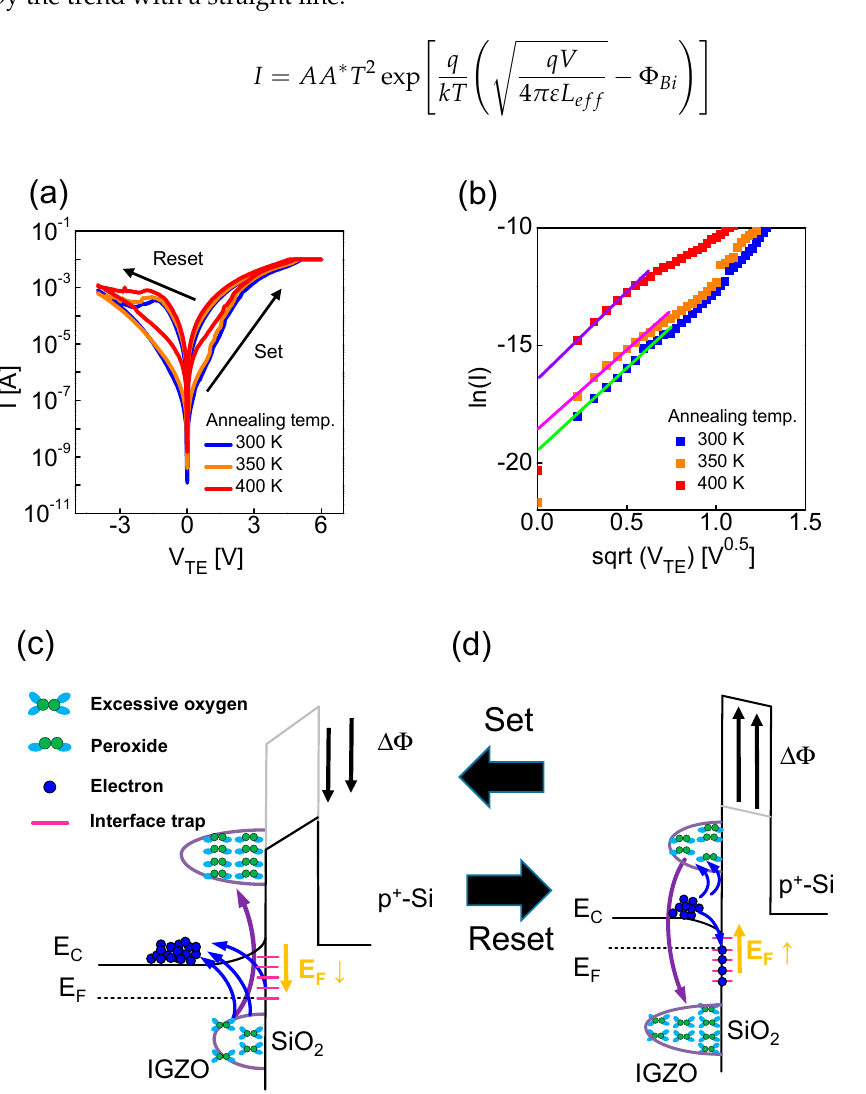
Figure 3. ( a ) I-V curves, including the set and reset processes in the devices with different annealing temperatures (300, 350, 400 K); ( b ) In(I) vs. sqrt(V TE ) for thermionic emission. EBD of IGZO/SiO 2 /p + -Si stack in the ( c ) low-resistance state (LRS) and ( d ) high-resistance state (HRS).